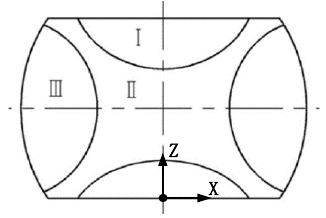
Figure 6. Classification of the deformation area.